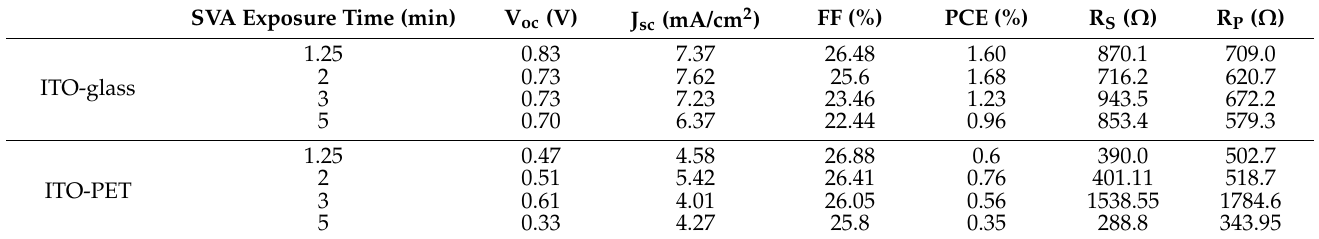
Table 3. Cell parameters of devices treated by SVA in DCM solvent at different exposure times.